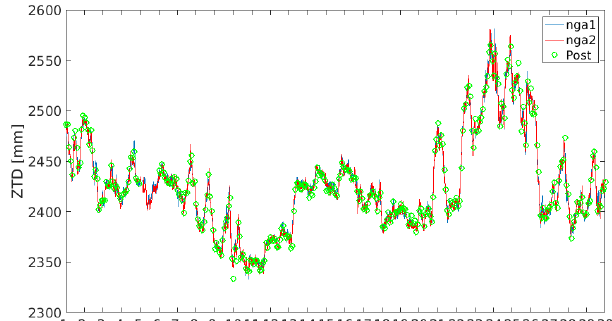
Figure 2. Time series of ZTD for June 2016 for the NGA1 (blue) and NGA2 (red) solutions together with the ones obtained from post-processing (green circles). The data are from the Ballerup (Copenhagen) station in Denmark. The x axis shows the days in June, whereas the y axis shows the ZTD